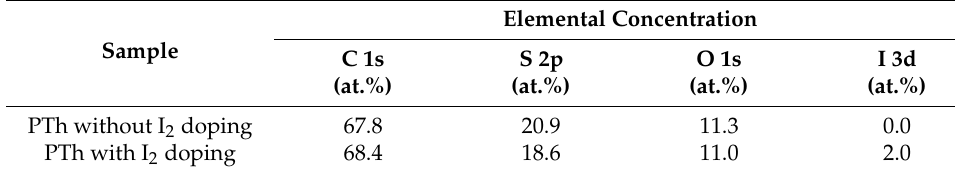
Table 1. Elemental concentration in atomic percentages of PTh films without and with I 2 doping observed in XPS spectra in Figure 3a.